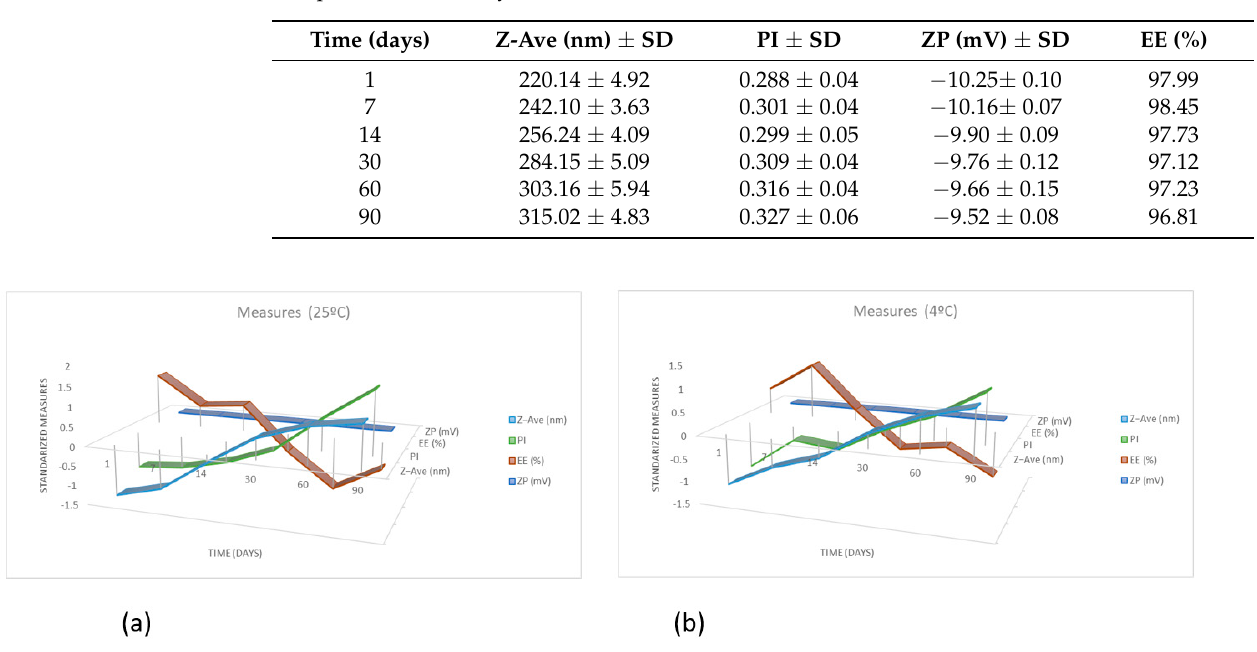
Figure 9. Graphics of the evolution of Z − Ave (nm), ZP (mV), EE (%) and PI over 90 days of PF-NLCs-N6 at 25 °C ( a ) ± and 4 °C ( b ) ( n = 3).